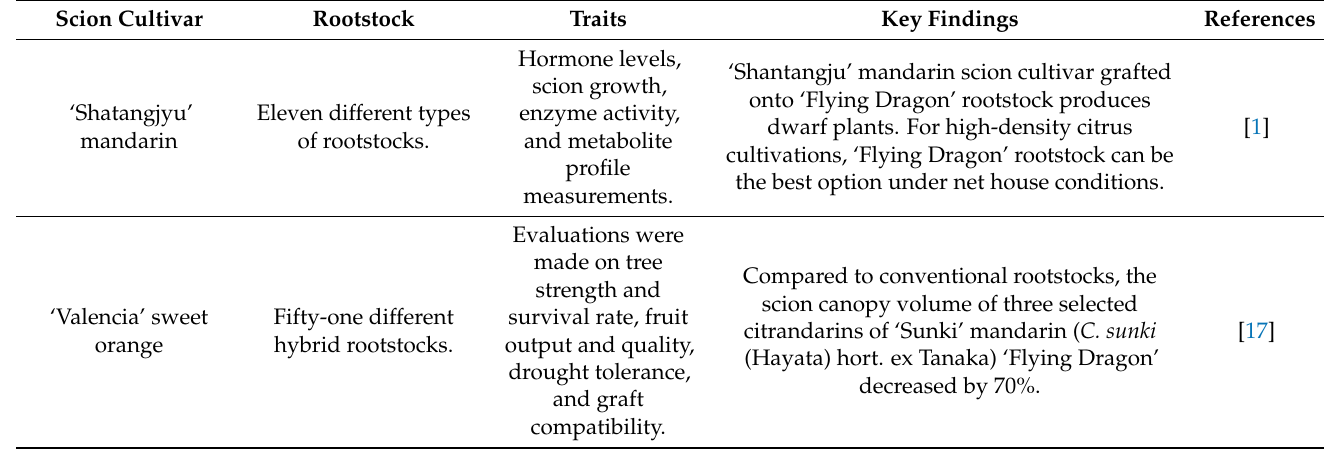
Figure 1. Schematic diagram of dwarfing mechanism in citrus rootstocks. Table 4. Rootstock-induced dwarfing effects in citrus scion